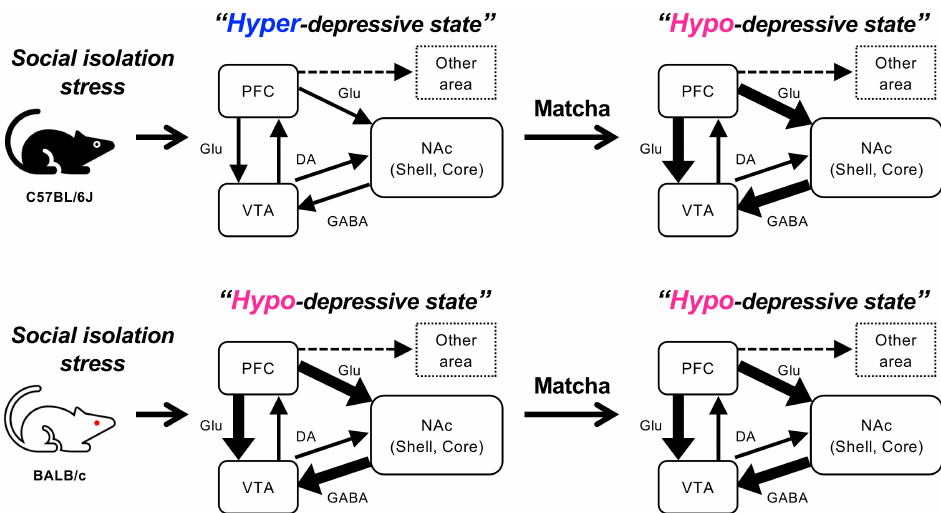
Figure 7. Matcha tea powder exerts antidepressant-like effect by activating the PFC-NAc-VTA circuit (dopaminergic system) in response to the mental states of mice. The depression state differs in strains of mice subjected to social isolation stress. Matcha tea powder exerts an antidepressant-like effect in C57BL/6J mice. Such effects of Matcha tea powder were not observed in BALB/c